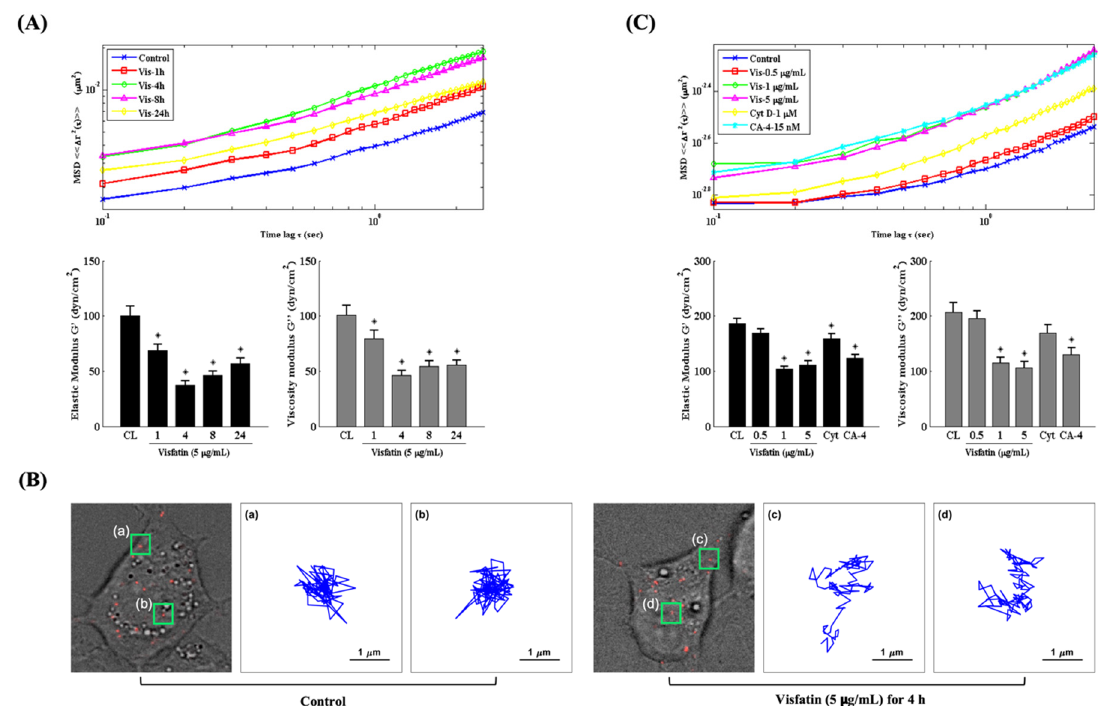
Figure 3. Visfatin changes the intracellular mechanics of human primary chondrocytes. ( A – C ) Human primary chondrocytes were injected with fluorescent beads and then kept as controls (CL) or treated with 5 µ g/mL of visfatin for 1, 4, 8 and 24 h or treated with 0.5, 1 or 5 µ g/mL of visfatin for 4 h. ( A , C ) The intracellular mechanics, i.e., the MSD and elasticity and viscosity moduli of human primary chondrocytes were analyzed by using the PTM method. ( B ) Actual examples of intracellular particle-tracking microrheology and the Brownian motion trajectory of the selected fluorescent beads at untreated control cells (a and b, left three panels) and 5 μ g/mL of visfatin treatment for 4 h (c and d, right three panels). *, p < 0.05 vs. untreated control cells (CL).